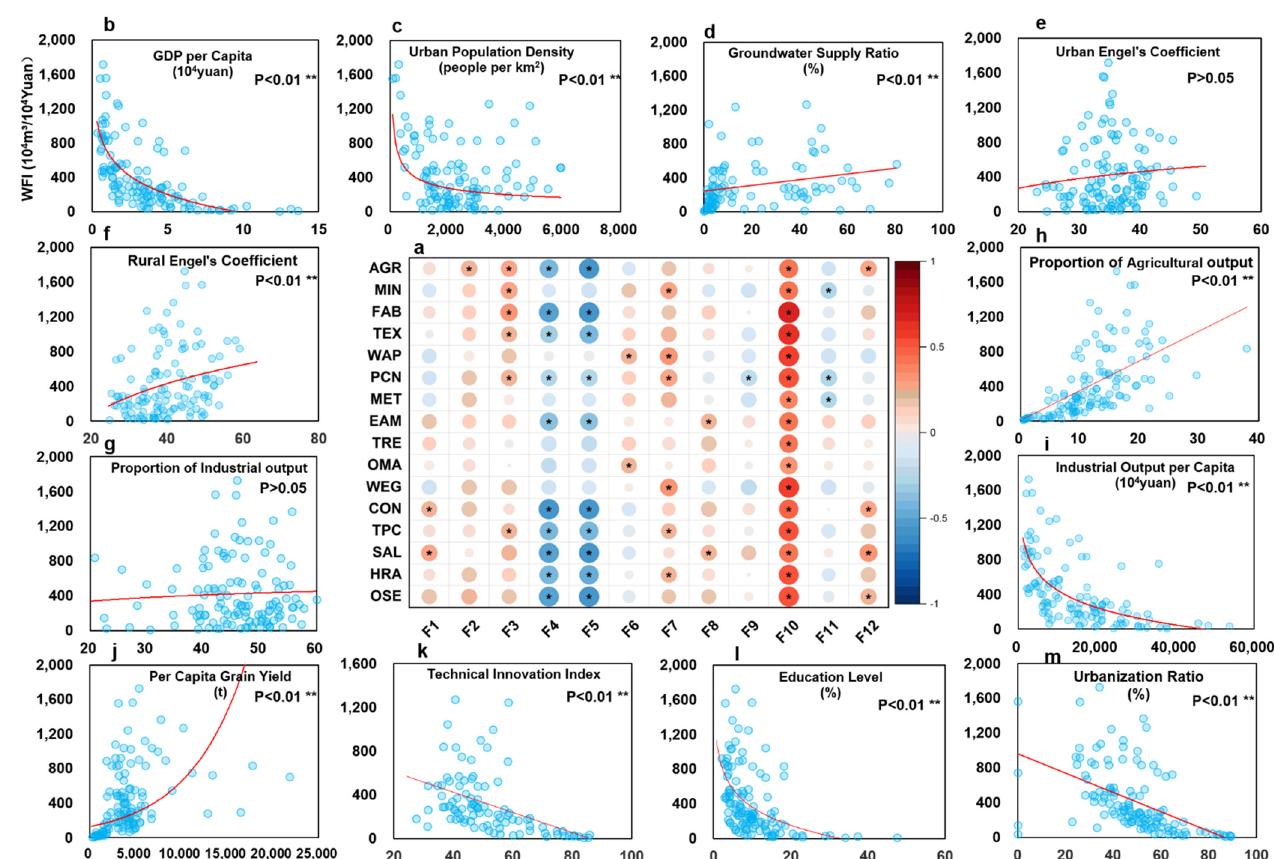
Figure 5. The relation between driving factors, WF, and WFI. Here, ( a ) represents the relationship between driving factors, while ( b – m ) reflect the relationship between driving factors and national WFI, on which P values are tagged. The “**” and “*” represent P value is less than 0.01 and 0.05,